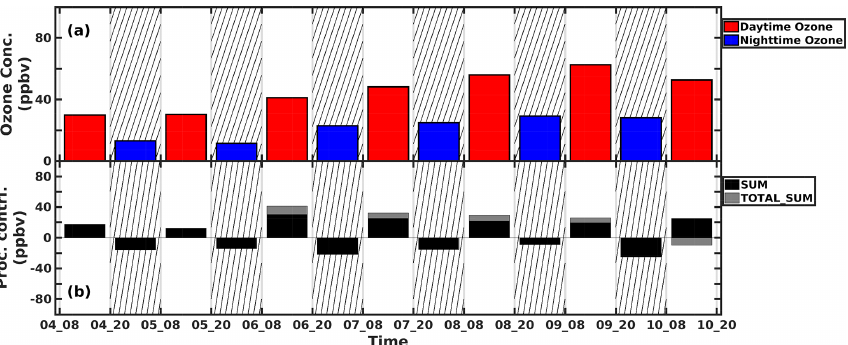
Figure 7. (a) Daytime and night-time ozone concentrations and (b) SUM and TOTAL_SUM on the ground within region D0 during 08:00 on 4 July to 20:00 on 10 July. Table 4. The decomposed accumulative CHEM, VMIX, CONV, and ADV effects of the TOTAL_SUM on the ground. Period